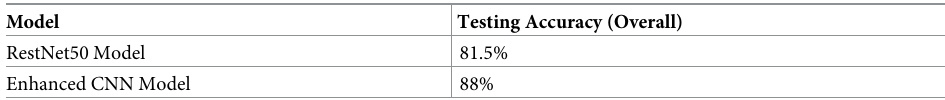
Table 2. Summary of performance of the models